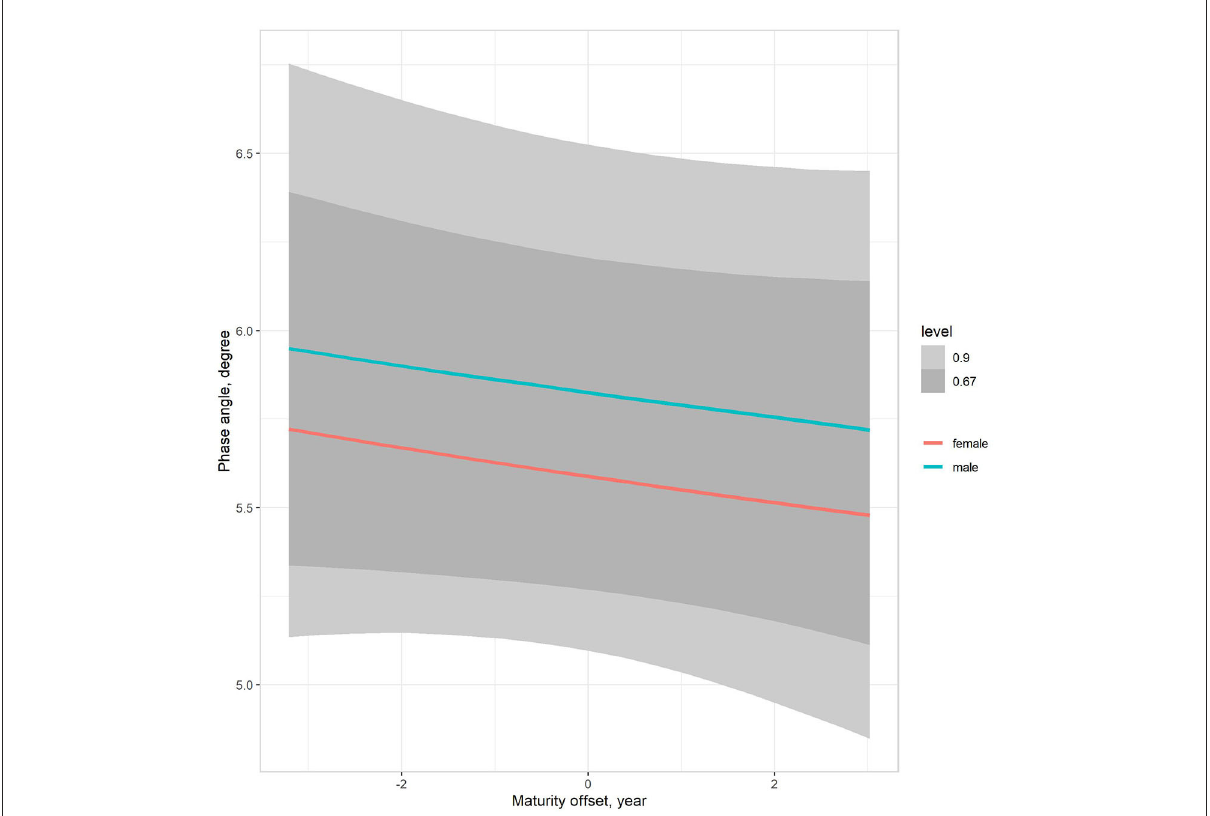
FIGURE4 Posterior estimations (67 and 90% CIs) of the association of the phase angle with estimated time before and after the age at PHV (maturity offset) by sex, adjusting for body